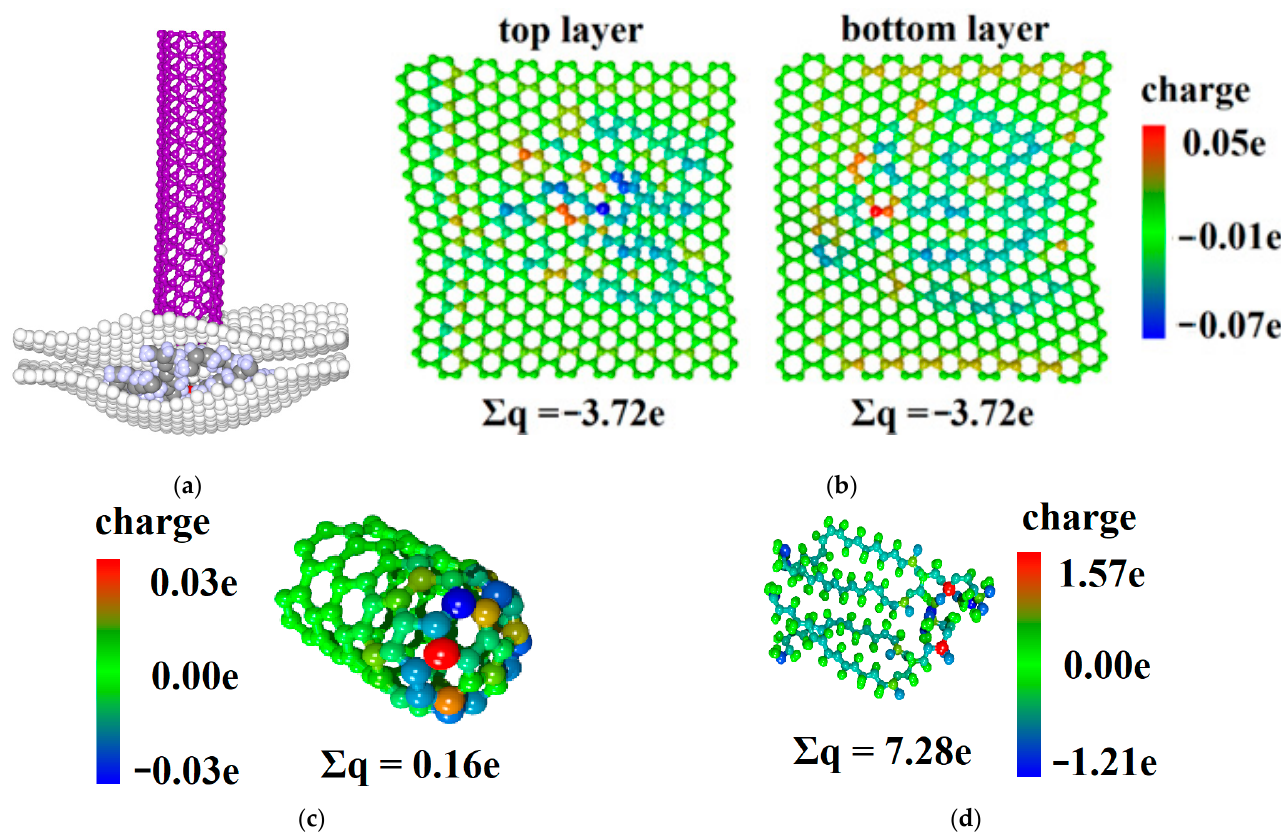
Figure 4. The analysis of the electron transfer in the CNT/graphene/DPPC system during nanoindentation ( a ) The fragment of the atomic structure graphene/DPPC with CNT at point F; ( b ) the distribution of Mulliken charges on atoms in the point for the upper (left) and the lower (right) graphene sheets; ( c ) for CNT; and ( d ) for DPPC.